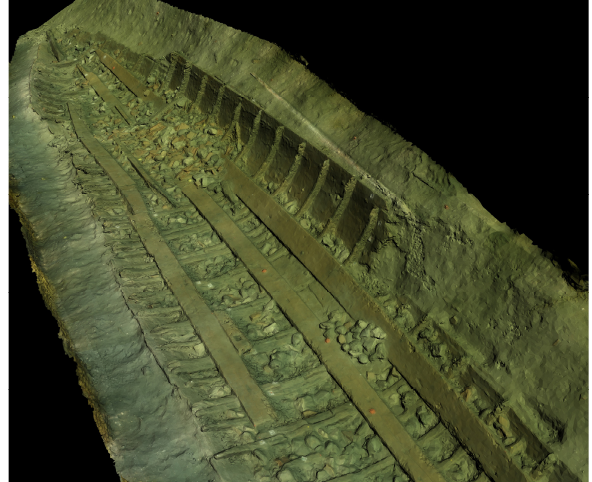
Figure 7. A shaded render of the ship’s 3-D